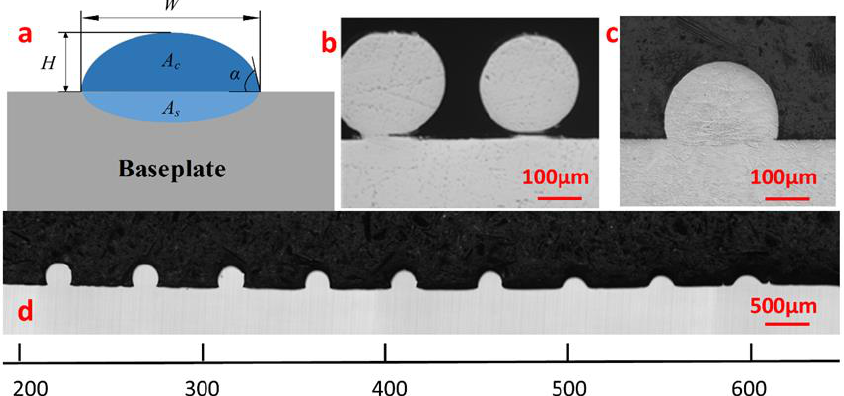
Figure 4. LJWF-DMD single-track cross-sections. ( a ) Geometry of the single-track section. ( b ) Single-track sections obtained using a single-laser heat source. ( c ) Single-track section obtained using a laser and Joule heating. ( d ) Single-track sections obtained at different baseplate heating tempera- tures.